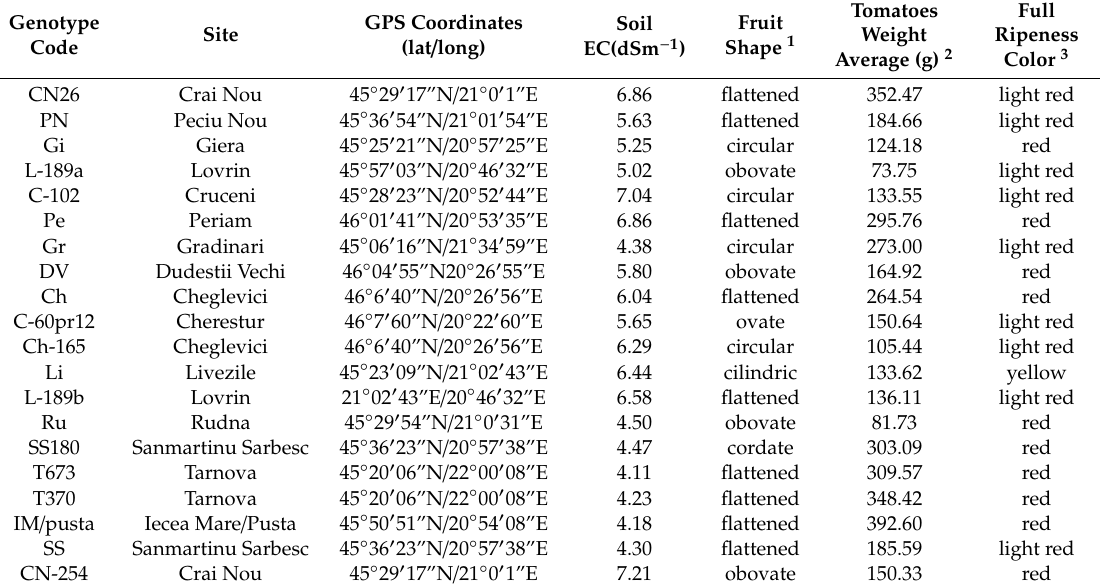
Table 1. Geographical origin, EC of origin soils, and the main morphological and productive characteristics of tomato